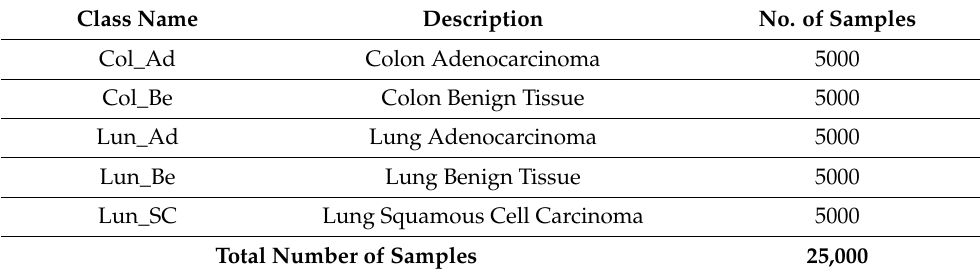
Table 1. Details of the